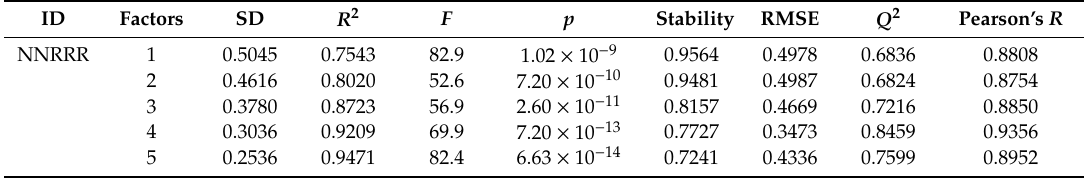
Table 4. Partial least square (PLS) analysis for statistically significant